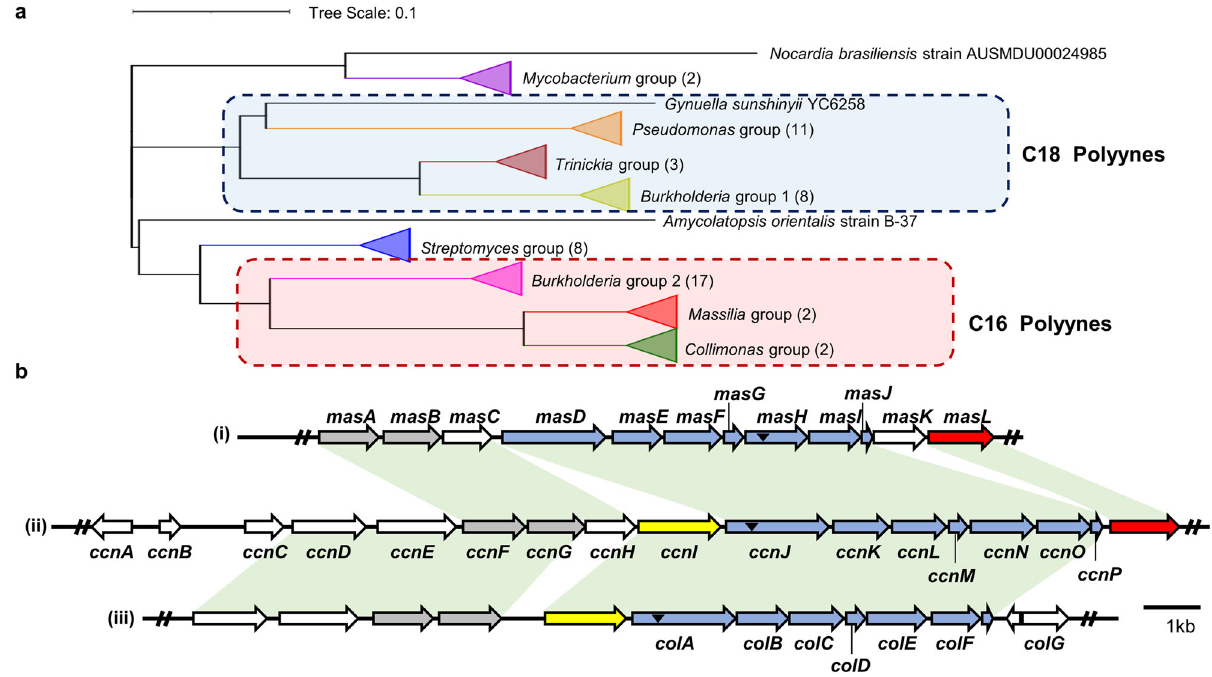
Fig. 3 Comparative analysis of polyyne biosynthetic gene clusters and the structures of the bacterial polyynes. a Phylogenetical analysis of polyyne biosynthetic gene clusters (BGCs) in bacteria (Supplementary Figs. 23 and 29). Species in the red box have been reported to produce palmitate-derived polyynes (C16), and species in the blue box have been reported to produce stearate-derived polyynes (C18). The number of BGCs in each group is shown in parentheses. b Comparison of the polyyne BGC architectures of mas BGC in Massilia sp. YMA4 (i), ccn BGC in B. ambifaria BCC0191(ii) 4 , and col BGC in C. fungivorans Ter331(iii) 7 . Genes conserved in polyyne BGC across the phylogenetic tree are shown in blue, and those conserved in the C16 polyyne group are shown in gray. The potential protective genes in the BGC are shown in red for acetyl-CoA acetyltransferase and in yellow for MFS transporter. The corresponding homologs (over 40% identity) in BGCs between two species are shown as the light green area. Black triangles indicate the mutation sites in previous research and this study.